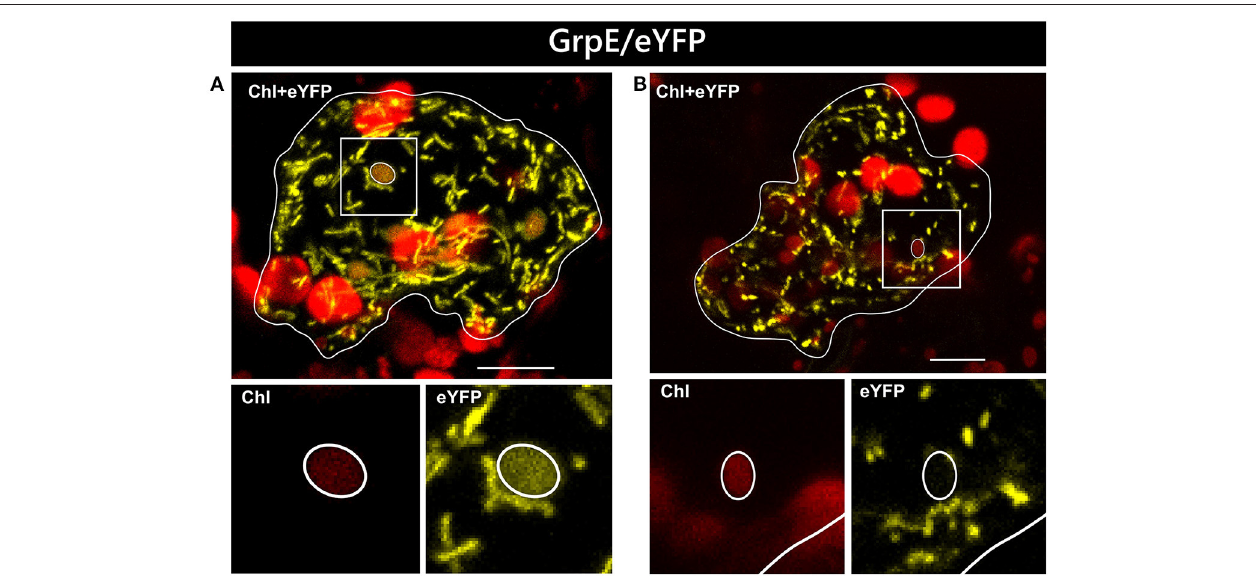
FIGURE 2 | Differential localization of GrpE/eYFP after particle bombardment. Particle bombardment of leaf epidermis cells of Arabidopsis thaliana with the GrpE/eYFP construct can lead to either dual localization of the candidate protein in both mitochondria and chloroplasts (A) or to mitochondrial localization solely (B) . For further details see the legend of Figure 1 .